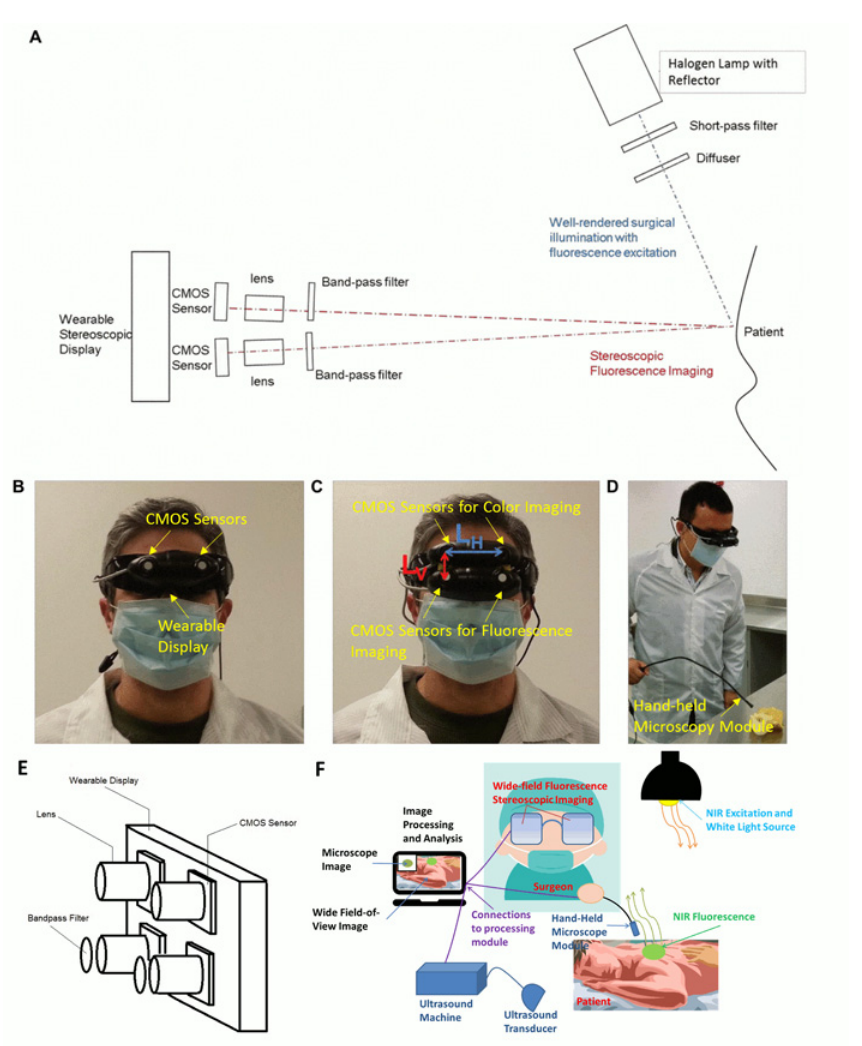
Fig 1. Prototype Integrated Imaging Goggles. (A) Schematic of 2-sensor setup. (B) Photo of 2-sensor setup for stereoscopic fluorescence imaging. (C) Photo of 4-sensor setup for simultaneous stereoscopic color reflectance imaging and fluorescence imaging. Top 2 sensors are for reflectance imaging and bottom 2 sensors are for fluorescence imaging. The horizontal and vertical inter-sensor distances are labeled in blue and red, respectively. (D) Integrated Imaging Goggle with its handheld in vivo microscopy probe. (E) Schematic of 4-sensor setup. (F) Overall system diagram depicting all components and connections during a typical operation with the hand-held microscopy module connected. Alternatively, a portable ultrasound scanner with transducer could be connected to the computational